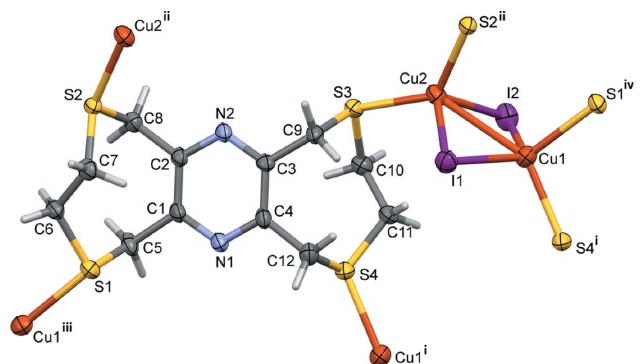
Figure 1 A view of the asymmetric unit of complex I , expanded to show the coordination environments of the two copper(I) atoms. Displacement ellipsoids are drawn at the 50% probability level. [Symmetry codes: (i) – x ,